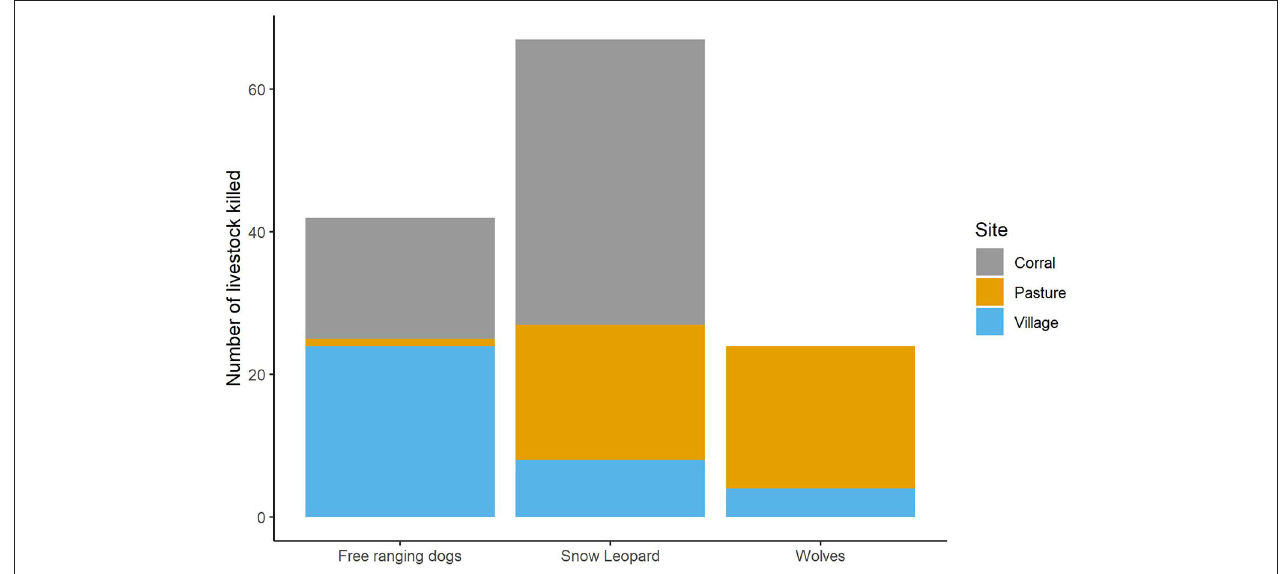
FIGURE 2 | Livestock depredation by snow leopards, wolves and free ranging dogs across livestock stocking pens (Corrals), pastures, and fields close to